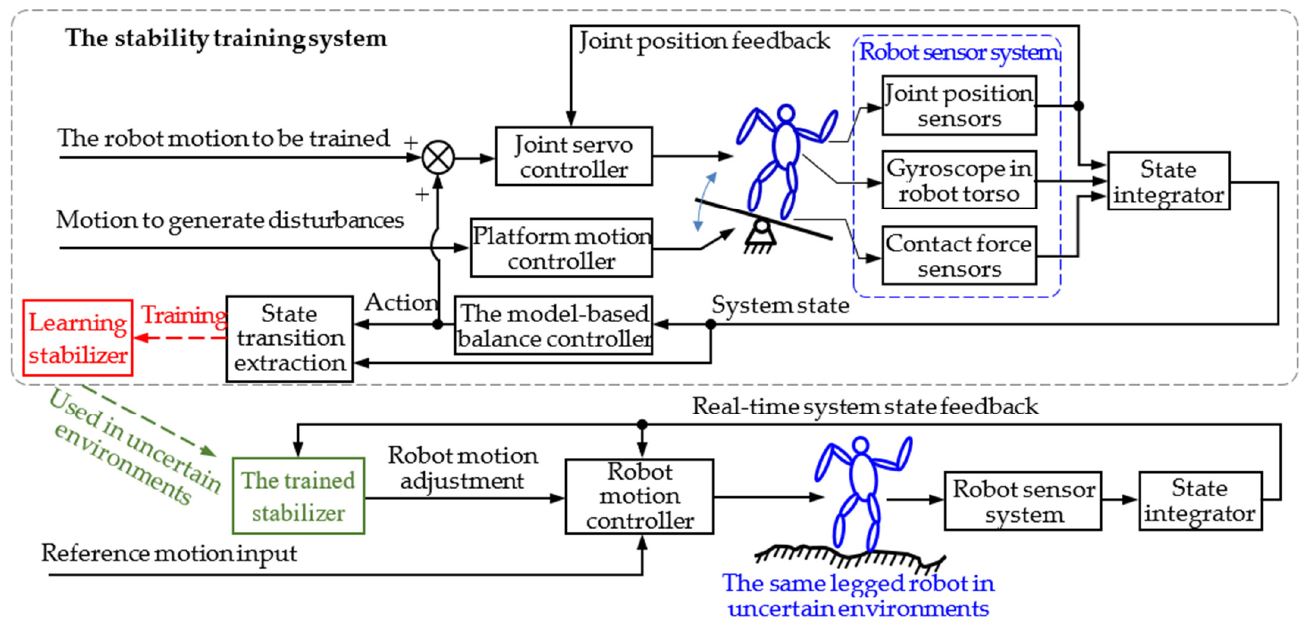
Figure 2. The basic idea of legged robot stability training and its application [25].